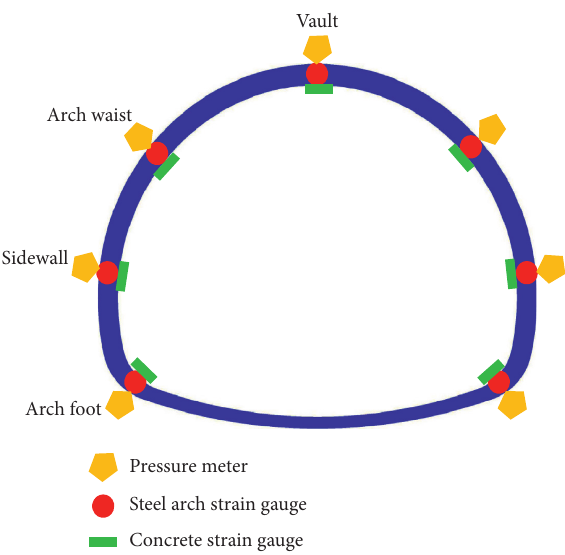
Figure 5: Layout of the measuring points in tunnel